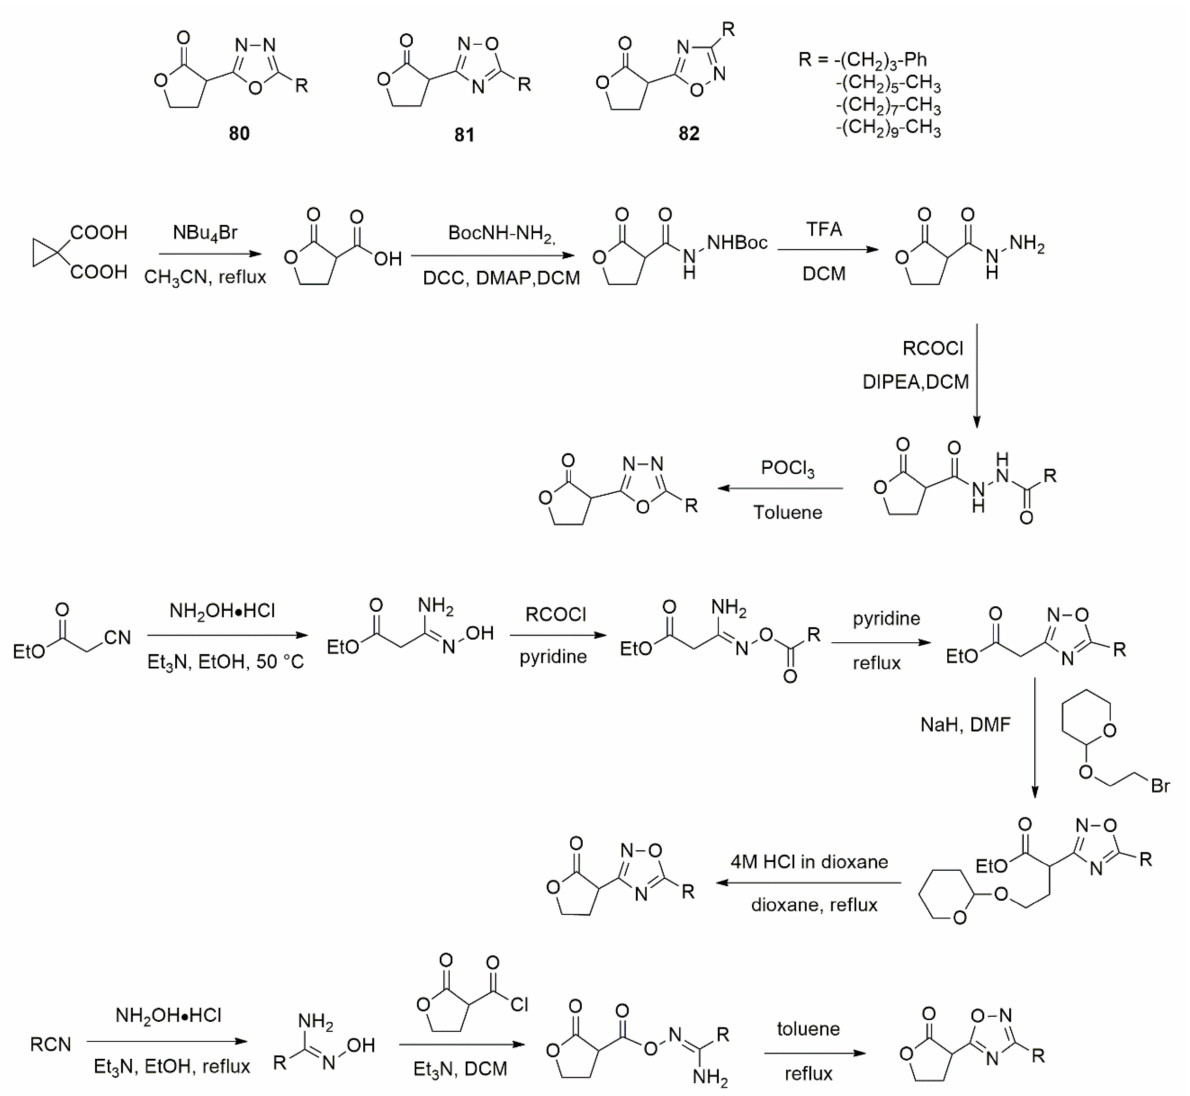
Scheme 10. Oxadiazole-containing QS inhibitor tested by our